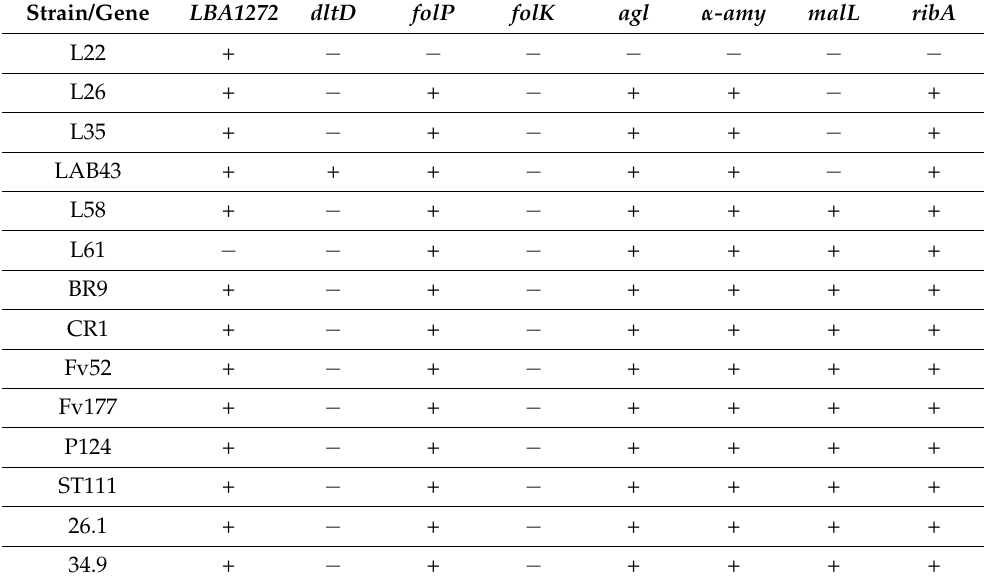
Table 8. Functional genes in the analyzed LAB strains.